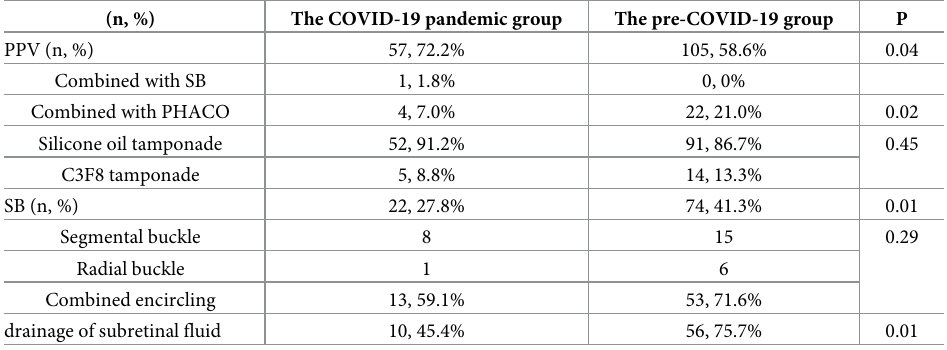
Table 1. The difference in treatment patterns between the two groups. (n, %) The COVID-19 pandemic group The pre-COVID-19 group P PPV (n, %) 57, 72.2% 105, 58.6% 0.04 Combined with SB 1, 1.8% 0, 0% Combined with PHACO 4, 7.0% 22, 21.0% 0.02 Silicone oil tamponade 52, 91.2% 91, 86.7% 0.45 C3F8 tamponade 5, 8.8% 14, 13.3% SB (n, %) 22, 27.8% 74, 41.3% 0.01 Segmental buckle 8 15 0.29 Radial buckle 1 6 Combined encircling 13, 59.1% 53, 71.6% drainage of subretinal fluid 10, 45.4% 56, 75.7%